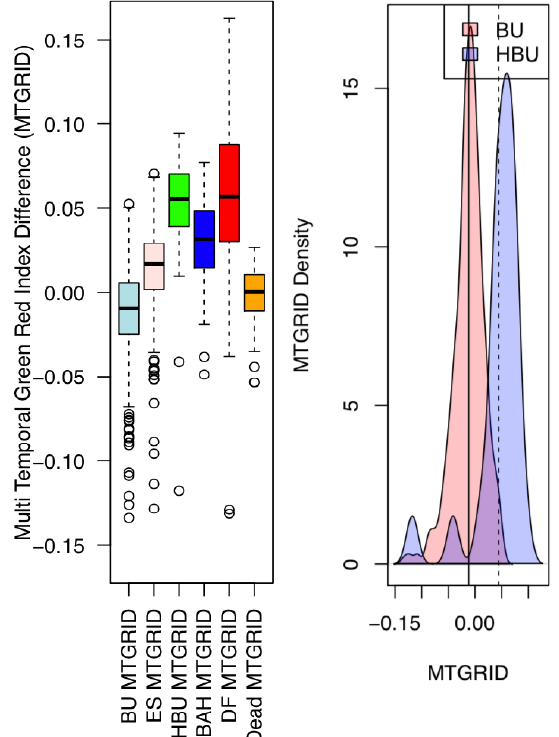
Figure 10: Multi Temporal Green Red Index Difference (MTGRID) feature for the quantification of the green-red spectral defoliation change signature (negative= convex shape, positive=concave